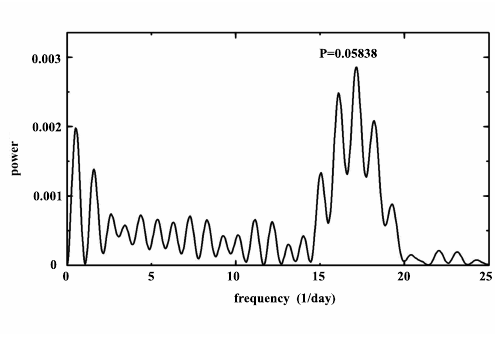
Figure 8: The power spectrum of